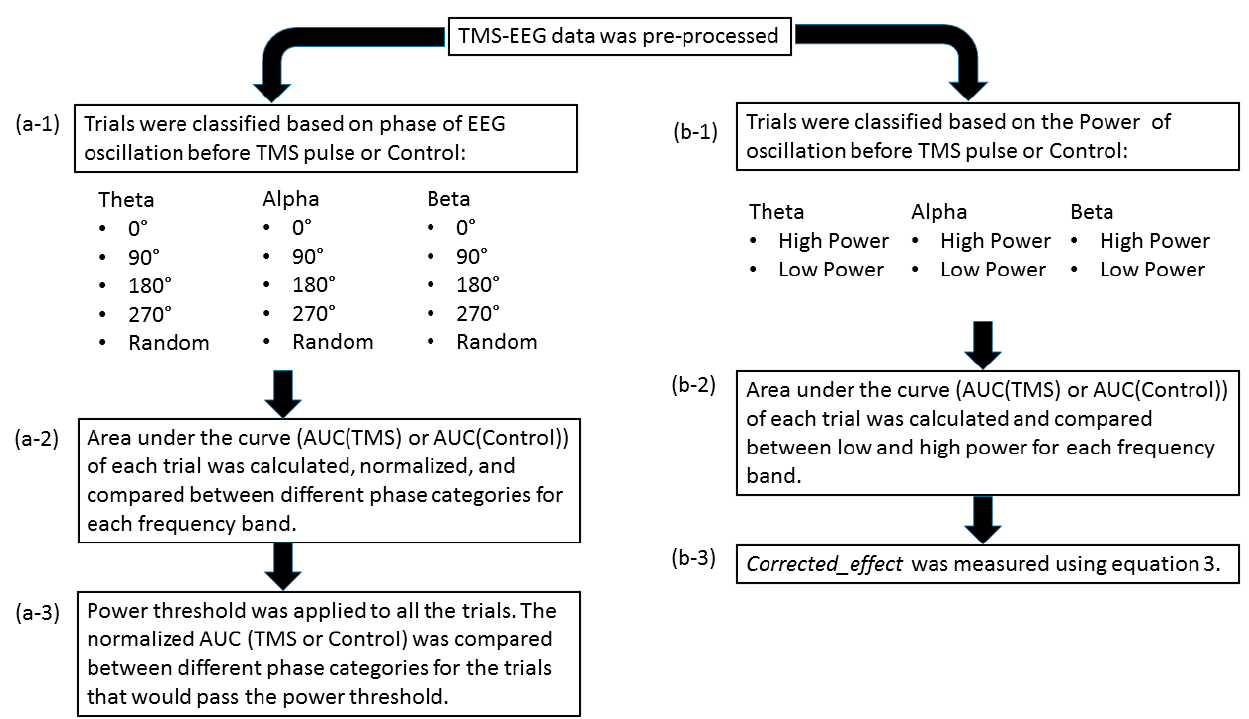
Figure 1. Overall post-processing analysis flow: ( a-1 ) the trials were classified based on the phase of the EEG oscillation before the TMS pulse or control condition using PHASTIMATE toolbox; ( a-2 ) the single-trial TMS-EEG-evoked response, measured by area under the curve of the waveform be- tween 25 and 80 ms (after the TMS pulse or the time of control condition), was compared between different phase categories in each frequency band; ( a-3 ) the mean of power for each subject and every frequency was set as the threshold, and then the AUC of the trials that would pass the thresh- old were compared between different phase categories in each frequency band; ( b-1 ) the trials were classified based on the power of the EEG oscillation before TMS pulse or control condition into high power (above the median—comprising 50% of the data) and low power (below the median) in each frequency band; ( b-2 ) AUC of high power and low power were compared in each frequency band; ( b-3 ) to isolate the effect of TMS from ongoing brain oscillation, corrected_effect was measured.